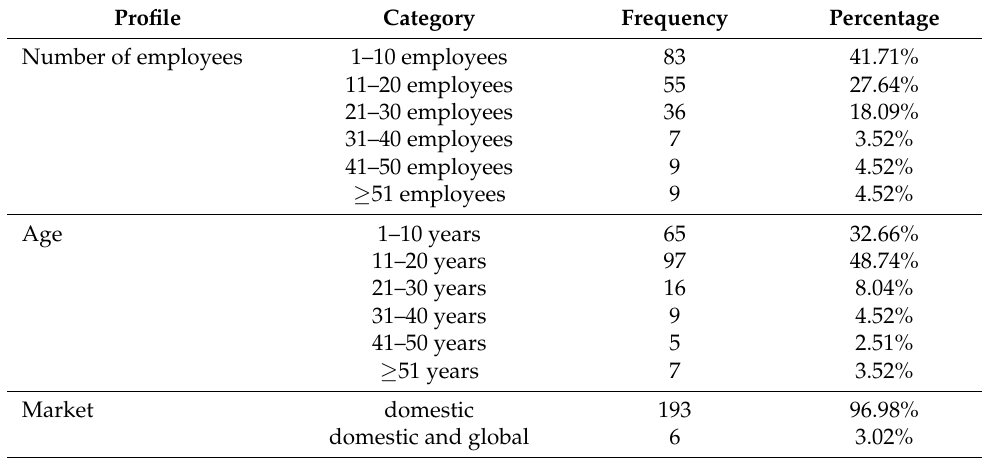
Table 1. Profile of